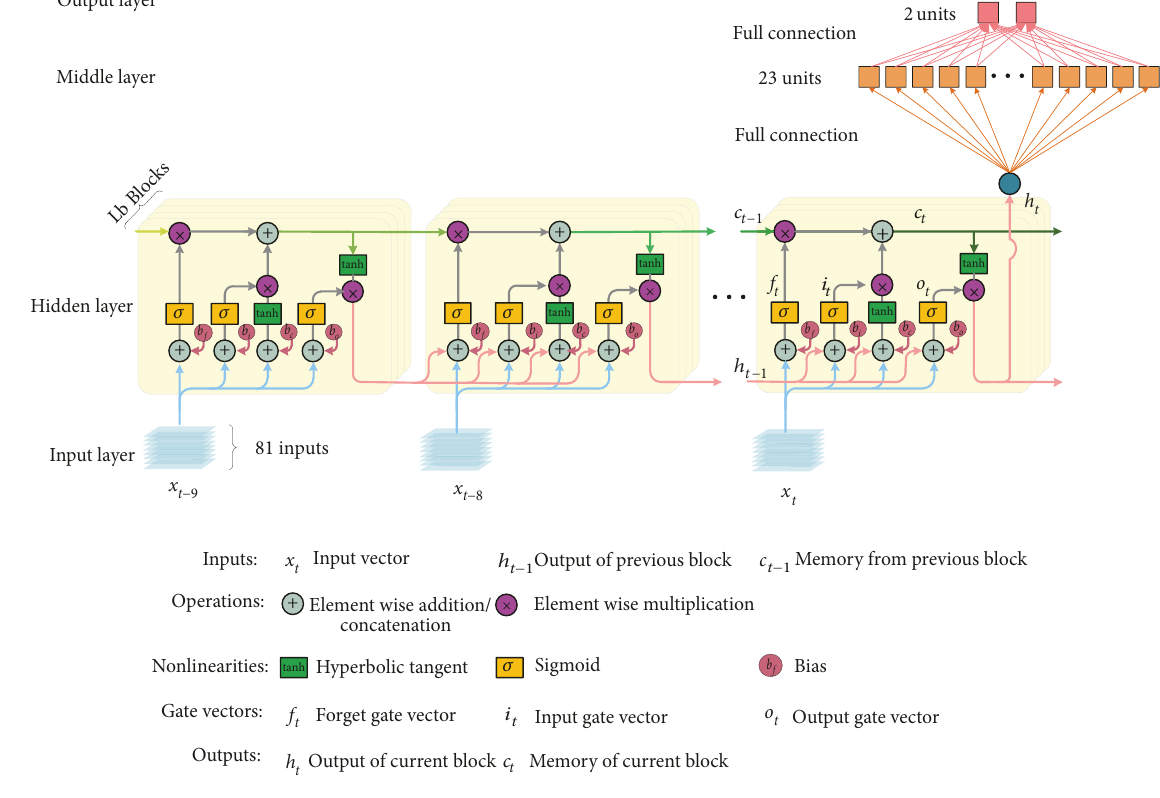
Figure 3: The network structure of